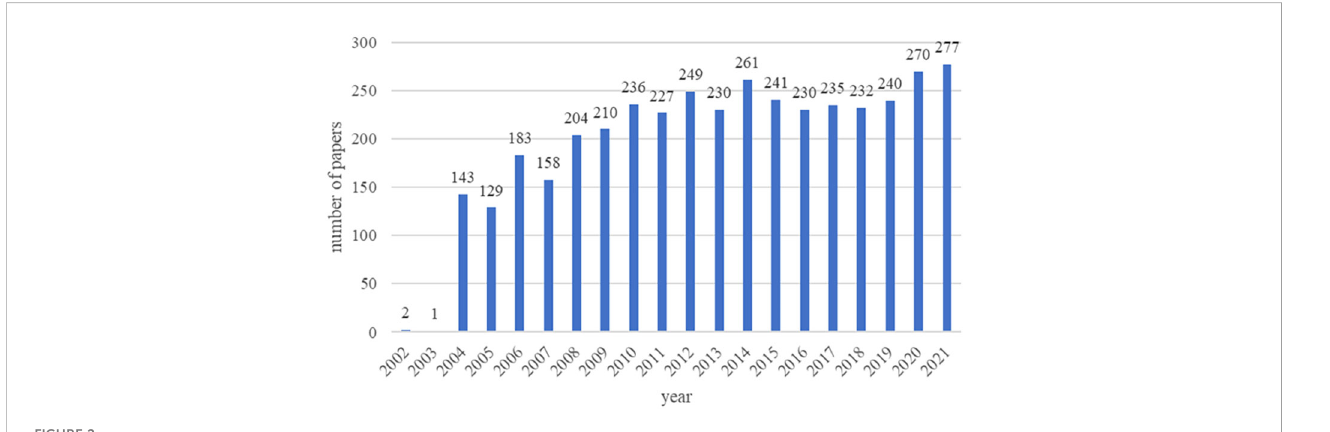
FIGURE 2 Trends of beta-cell publications over the past 20 years.